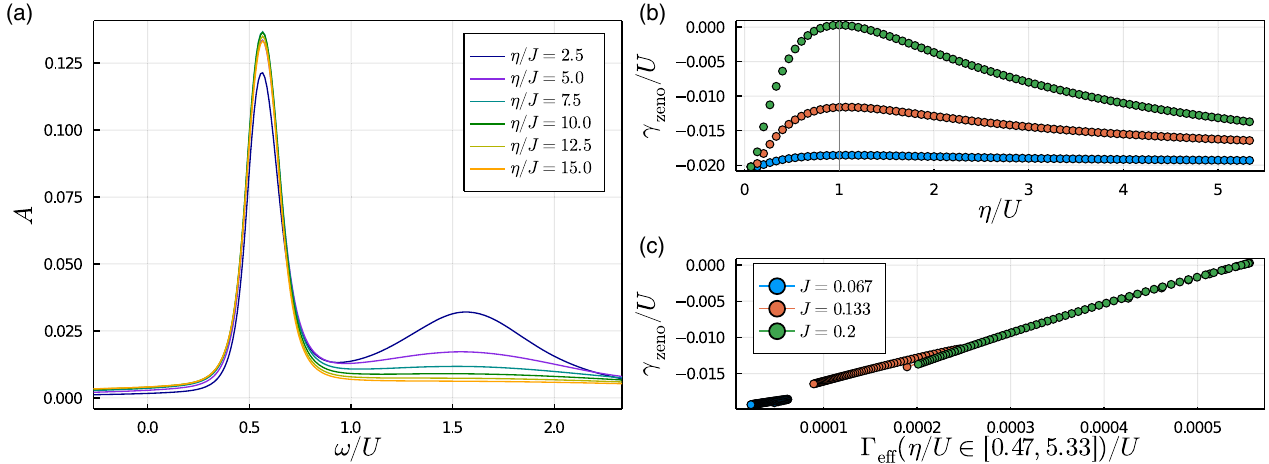
FIG. 17. Quantum-Zeno regime in the spectral function, increasing two-particle-loss rate η at fixed drive rate f=U ¼ r η =U ¼ 0 . 013 20 , dt ¼ 0 . 002 , and dim 6 . (a) Spectral function at increasing η =J and for J=U ¼ 0 . 133 . and for z ¼ 6 ; U ¼ 15 . Parameters: t H ¼ max ¼ The first peak corresponds to transitions between states with on-site occupation n ¼ 0 and n ¼ 1 , while higher-energy peaks are suppressed at large η =J . We fit the first peak as described in the main text in order to extract a measure of its lifetime γ . (b) Partial lifetime γ =U of the first peak of the spectral function obtained by removing the zero hopping and zero drive or dissipation contributions. We Zeno show that this quantity has a nonmonotonic behavior, analogous to the populations in Fig. 3, manifesting a quantum-Zeno behavior in =U depends only on the dissipative scale Γ =U , analogously to the occupation the lifetime of excitations of the steady state. (c) γ Zeno eff probability ρ 1 as shown in the inset in Fig. 3. In (b), (c) J=U ¼ ½ 0 . 067 ; 0 . 133 ; 0 . 2 (cid:2)